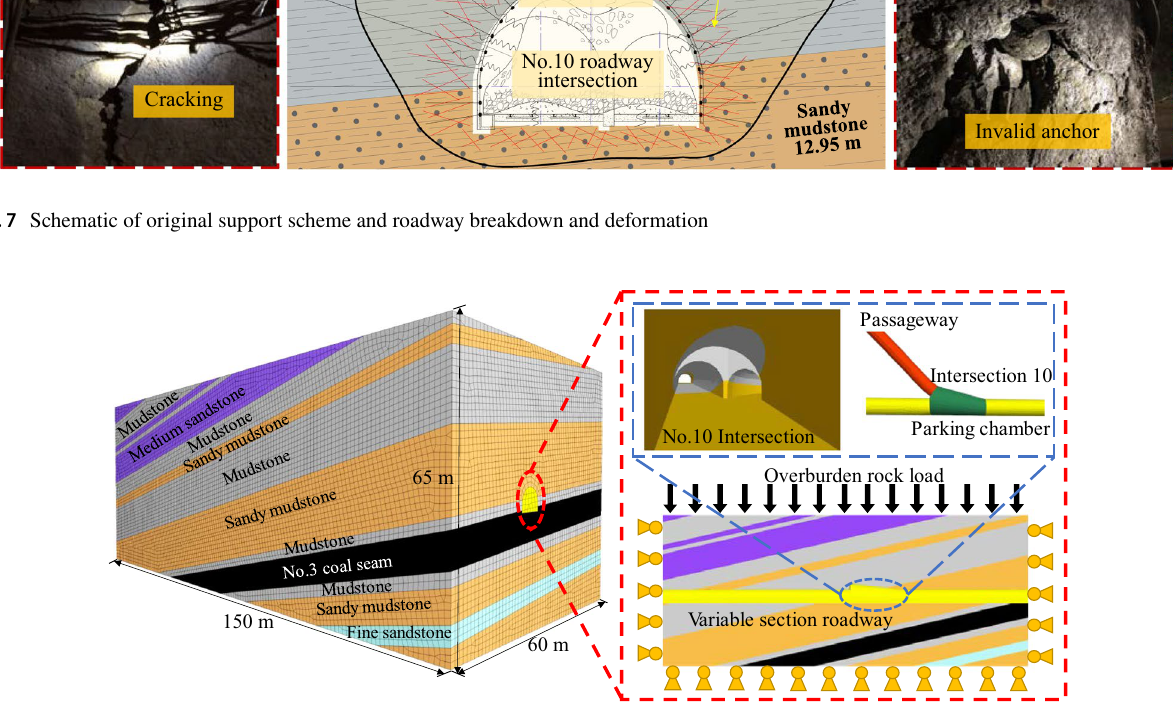
Fig. 8 FLAC 3D numerical model of the No. 10